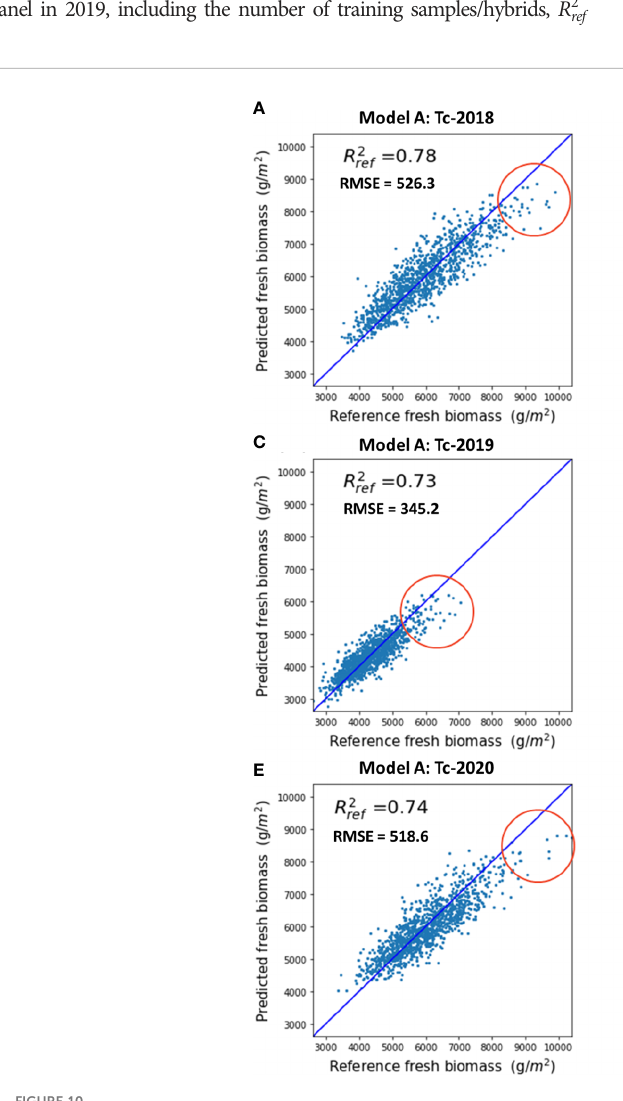
FIGURE 10 Performance of single year biomass prediction: (A) Model A on the 2018 Tc panel, (B) Model B on the 2018 Tc panel, (C) Model A on the 2019 Tc panel, (D) Model B on the 2019 Tc panel, (E) Model A on the 2020 Tc panel, (F) Model B on the 2020 Tc panel. Red circles show the improvement of the prediction results with genetic information, which occurred for high biomass reference values, typically associated with photoperiod sensitive